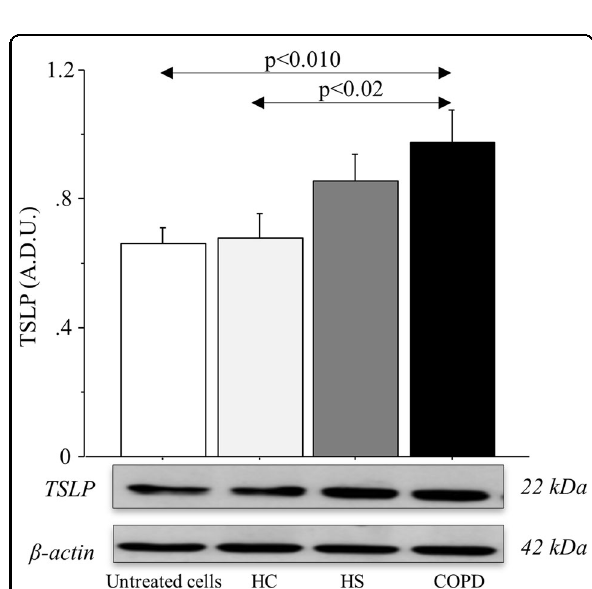
Fig. 2 TSLP production in 16HBE cells stimulated with ISs from HC ( n = 6), HS ( n = 6), and COPD patients ( n = 6). TSLP was detected in protein extracts by western blot analysis as described in the “ Materials and methods ” section. Bars represent the mean ± SD of arbitrary densitometric units (A.D.U.), normalized to β -actin, which was used as the loading control. Representative gel images of the experiments are shown. ANOVA with Fisher ’ s test correction was used to analyze data. A p value < 0.05 was considered statistically signi fi